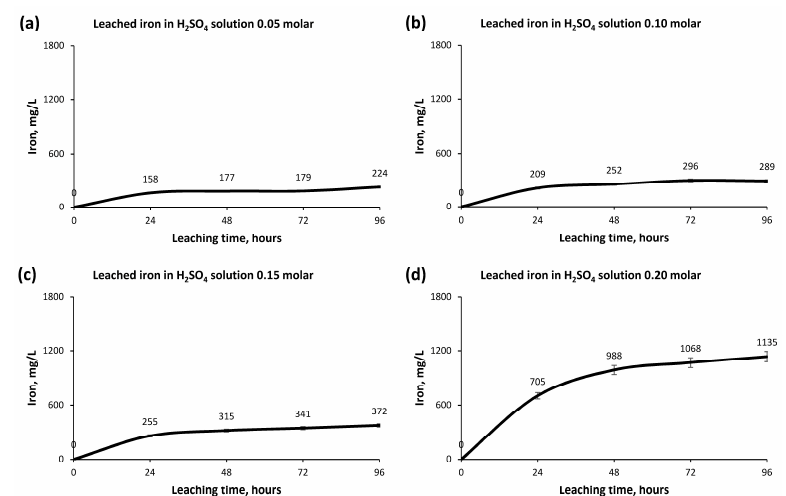
Figure 5. Analysis of the Iron concentration in the leaching process at atmospheric pressure, ambient temperature and in different Sulphuric Acid solutions: ( a ) 0.05 molar H 2 SO 4 solution, ( b ) 0.10 molar H 2 SO 4 solution, ( c ) 0.15 molar H 2 SO 4 solution and ( d ) 0.20 molar H 2 SO 4 solution.